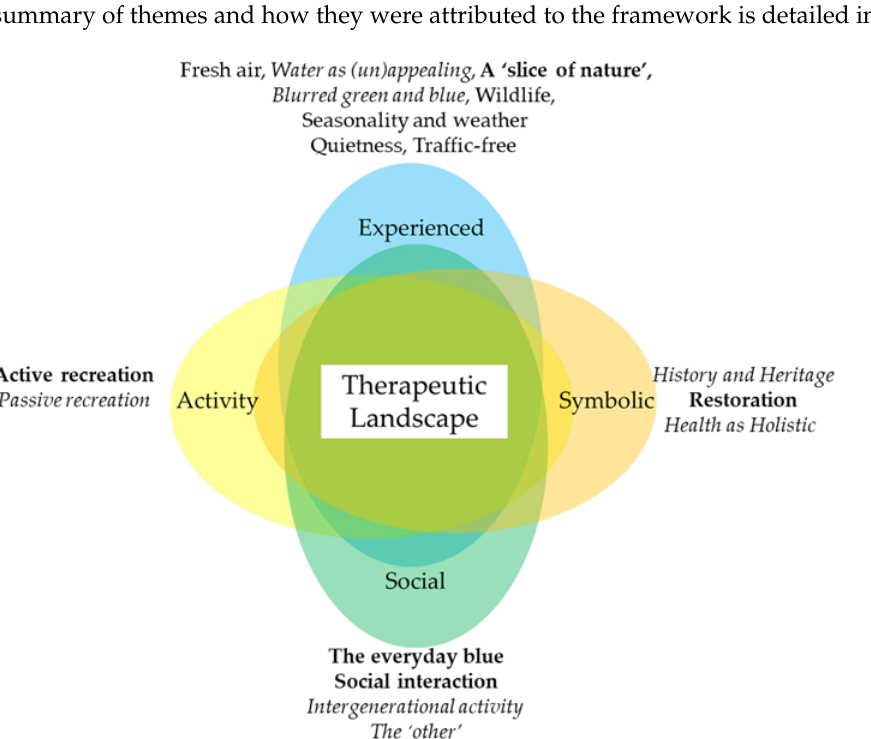
Figure 4. Inductively identified themes categorised within Volker and Kistemann’s (2011) conceptual framework of therapeutic landscapes. Italicised themes mentioned by fewer than 10 participants, while bold themes mentioned by over 25 [6].